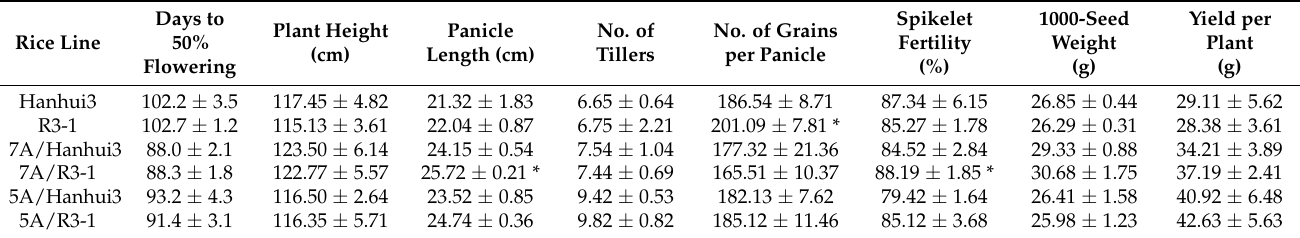
Table 3. The yields and agronomic performances of NIL and its derived hybrids under normal field